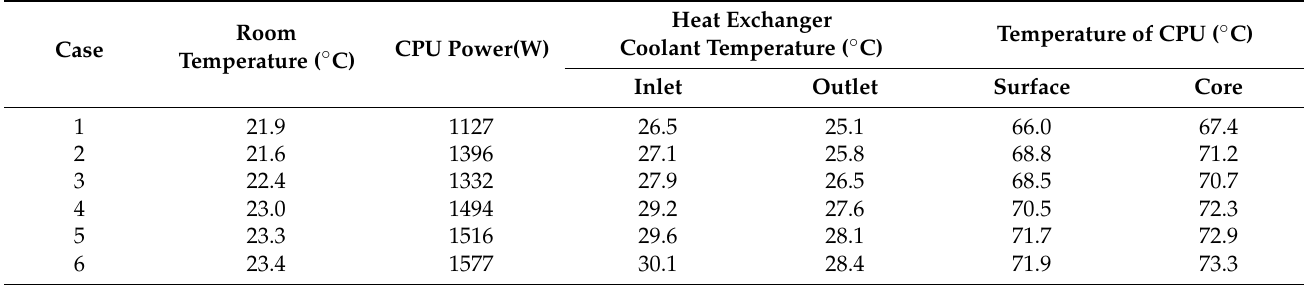
Table 2. Operating conditions and experimental